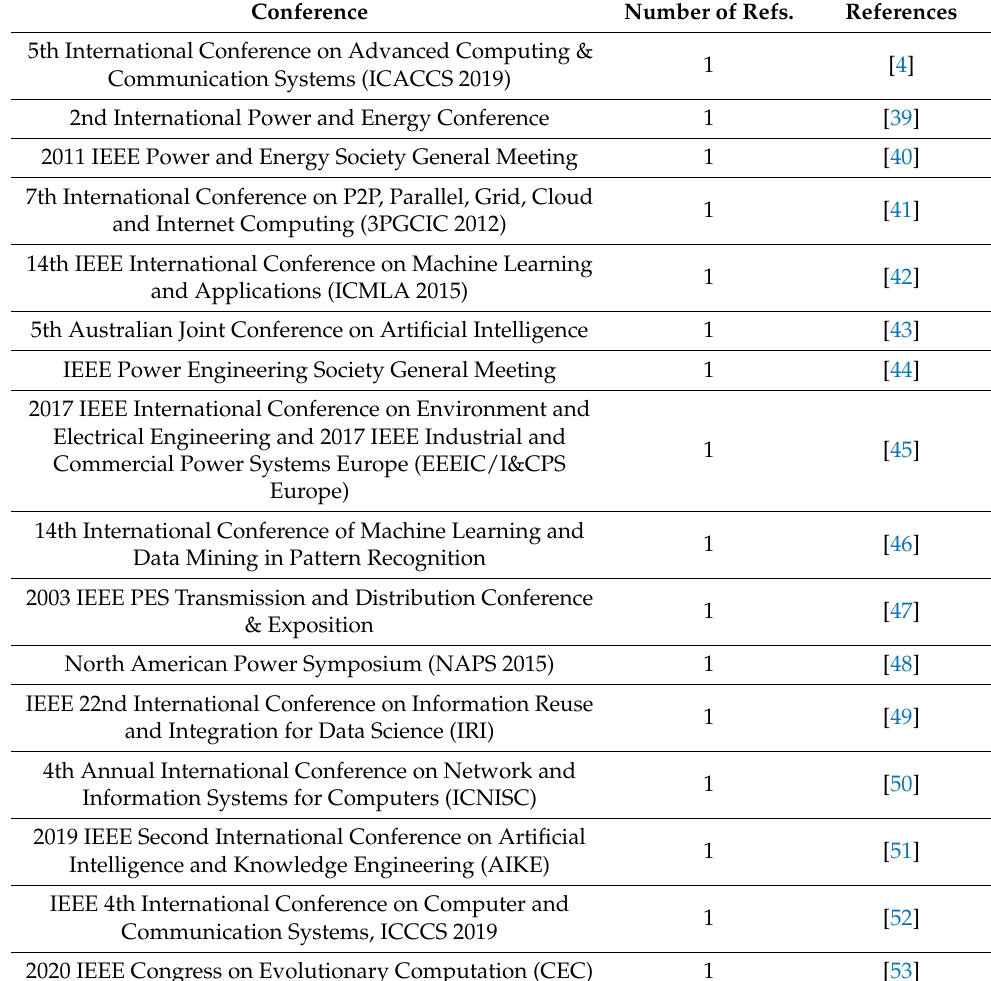
Table 3. Selected papers according to